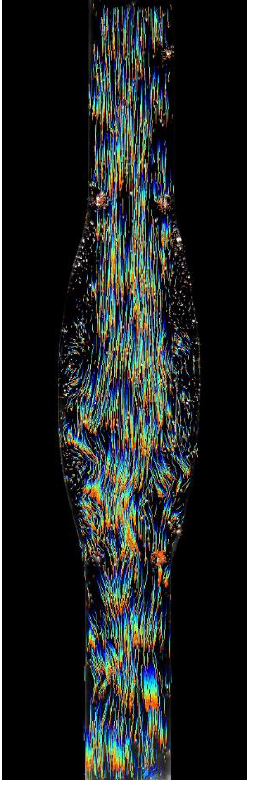
Figure 3. Example of reconstructed trajectories, run 6.